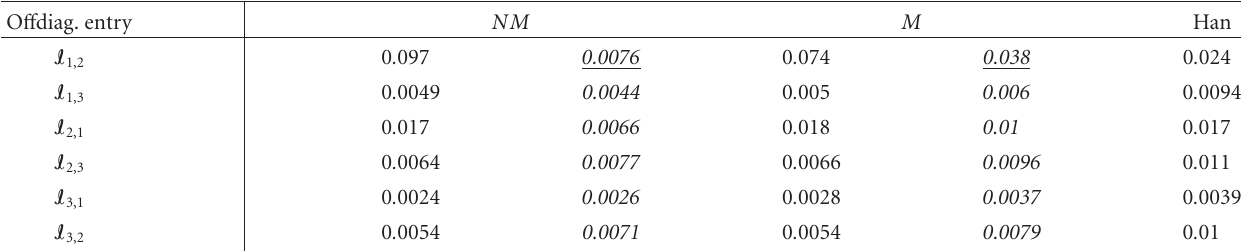
Table 3: Standard deviations of the o ff diagonal entries I ij defined by (22) obtained while separating realistic component maps by joint diagonalization of covariance matrices in Fourier space, with ( M ) or without masking ( NM ) part of the data, or applying an apodizing Hanning window (Han). Components 1, 2, and 3, respectively, stand for CMB, dust, and SZ. The numbers in italic were obtained with Gaussian maps and the underlined numbers correspond to the histograms in Figure 6. O ff diag. entry